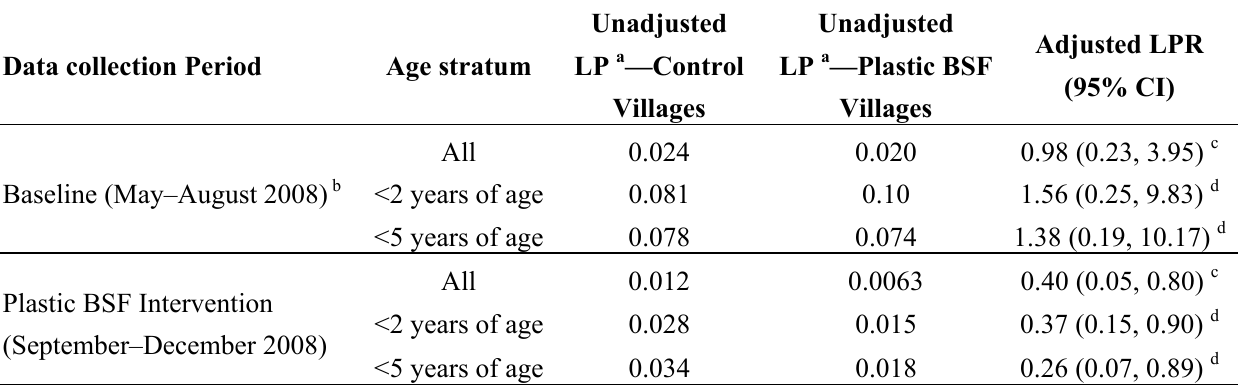
Table 3. Adjusted longitudinal prevalence ratios for diarrheal disease, stratified by age, during the pre-intervention and intervention phases of a randomized controlled trial of the plastic BSF in rural Tamale, Ghana